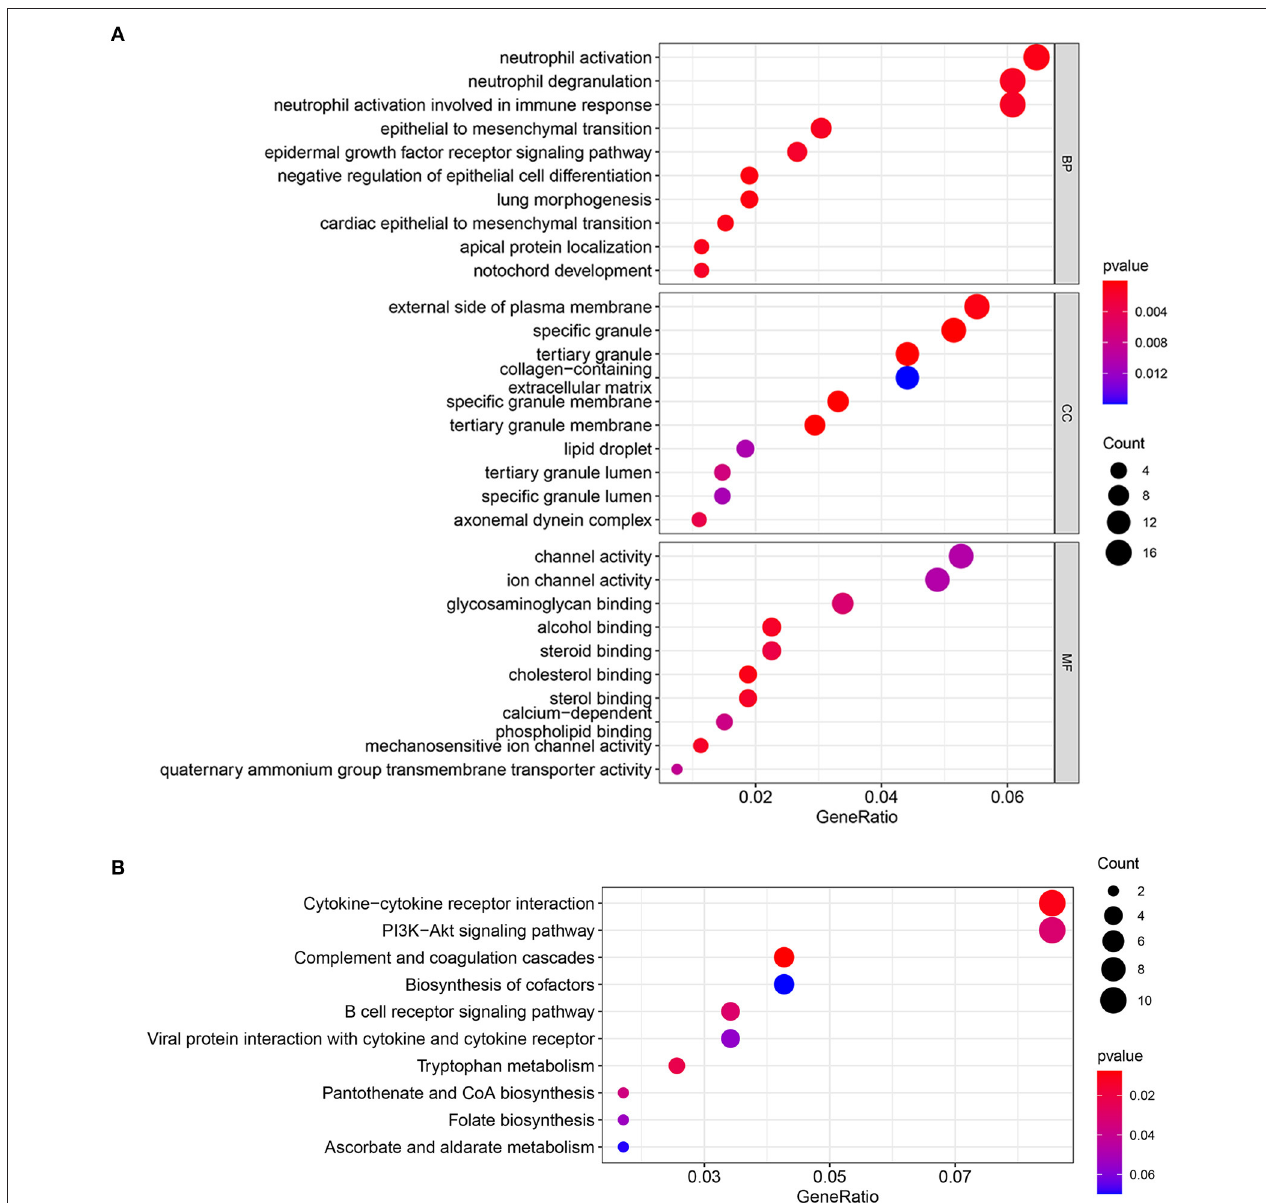
FIGURE 3 | (A) GO enrichment analysis for DEmRNAs. (B) KEGG pathway enrichment analysis for